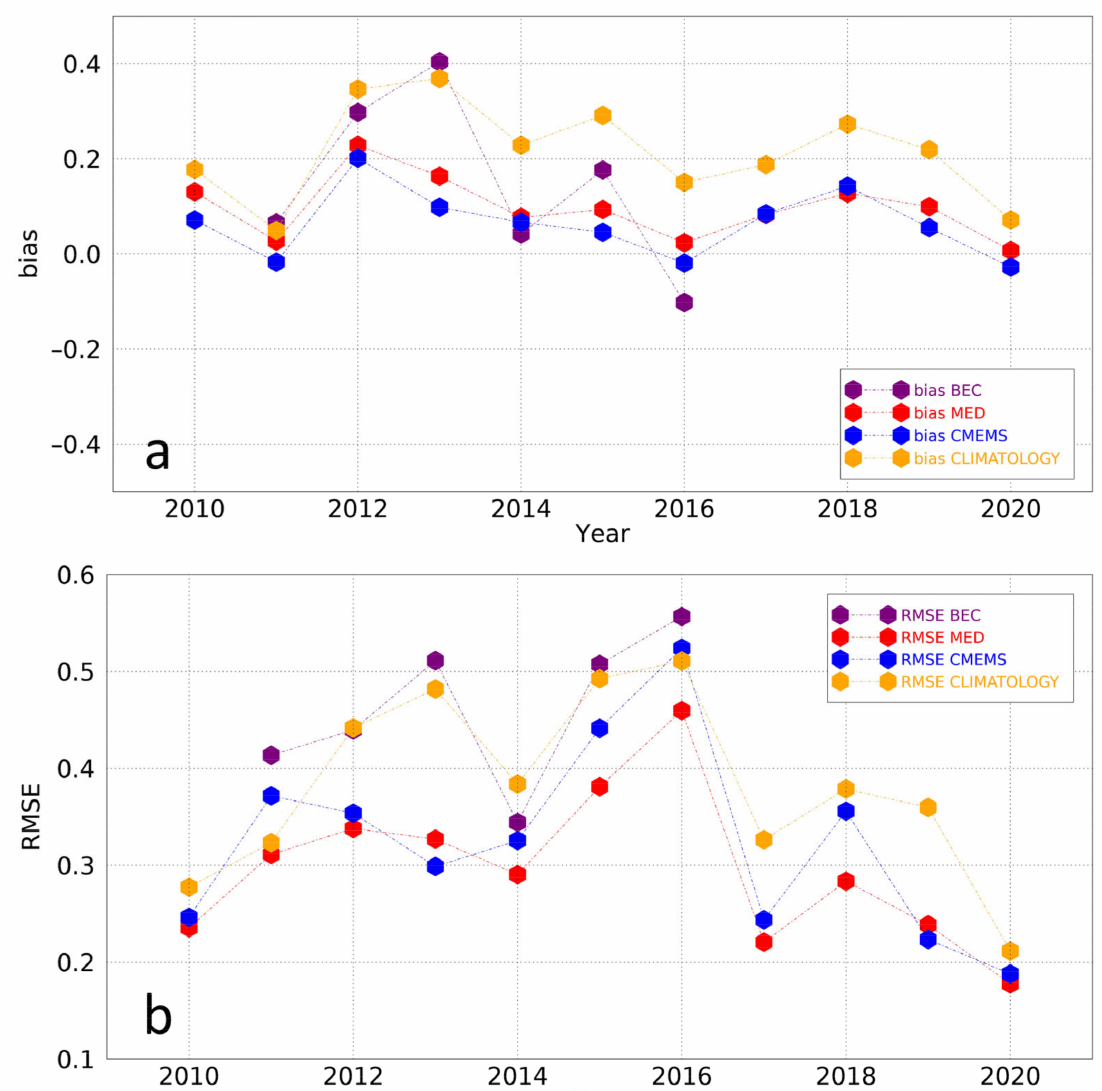
Figure 6. Interannual variability of mean bias ( a ) and RMSE ( b ) computed between in situ and L4 SSS products from 2010 to 2020. The statistic for the year 2011–2016 is computed on the same number of BEC L4 SSS